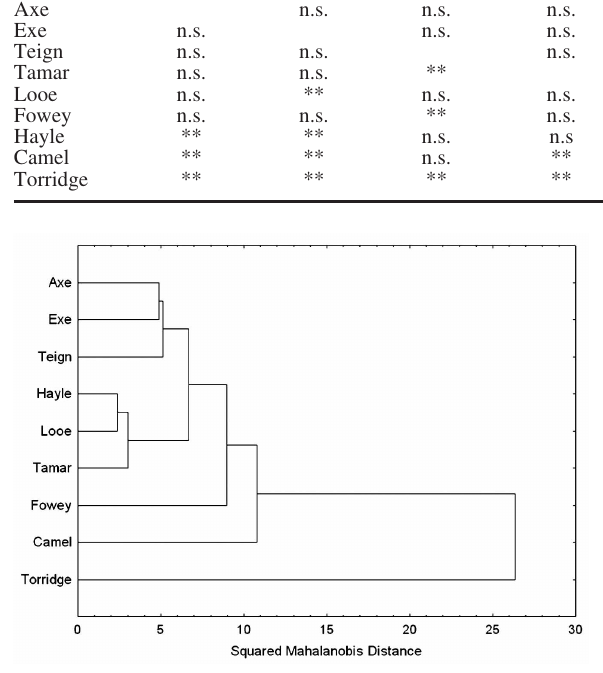
Fig . 6. – UPGMA dendrogram derived from cluster analysis of squared Mahalanobis distances for relative warp scores, for the ma- jor chela of Carcinus maenas